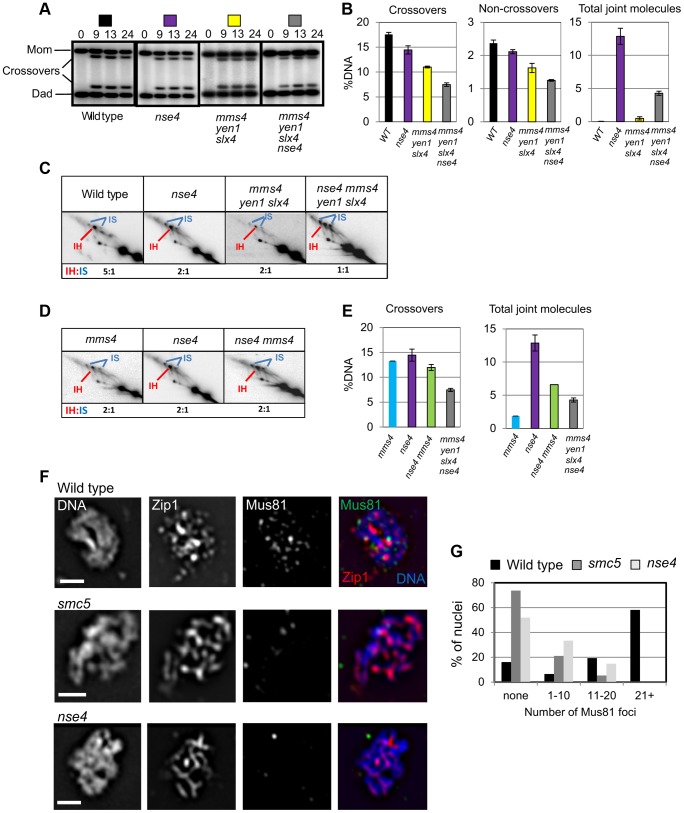
Smc5/6 regulates joint molecule resolution by Mus81-Mms4.(A) Representative images of 1D analysis of crossover levels. (B) Quantification of crossovers, non-crossovers, and total joint molecule levels at meiotic endpoints (13 hours). Quantification from three independent diploids; error bars represent the standard deviation. (C) Representative images of 2D analysis of IH∶IS ratio in nse4 and nse4 mms4 yen1 slx4 quadruple mutants in the ndt80Δ background (13 hours). Data from three independent diploids. (D) Representative images of 2D analysis of IH∶IS ratio in nse4 and nse4 mms4 mutants the ndt80Δ background (13 hours). Data from three independent diploids. (E) Quantification of crossovers and total joint molecules in nse4 mms4 mutants compared to individual single mutants and the nse4 mms4 yen1 slx4 quadruple mutant. (F,G) Representative images of Mus81 foci on spread, meiotic nuclei and quantification of Mus81-9myc foci. Nuclei were selected on the basis of linear Zip1 structures (pachynema). 100 nuclei were assessed for each strain. For the mms4 single strain, we ran only one diploid in parallel with the nse4 mutants. These data were similar to those described previously [14]. Strains: WT (Y3137), smc5 (Y3135), and nse4 (Y3144).